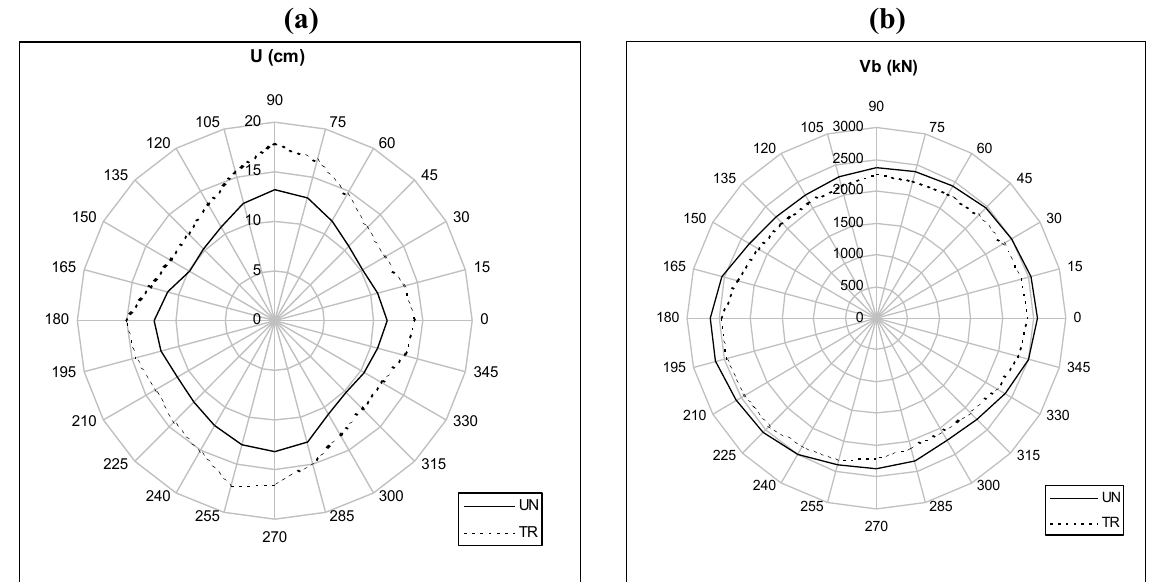
Figure 2. ( a ) Capacity Domains in terms of node control displacements at collapse; ( b ) Capacity Domains in terms of base shear.